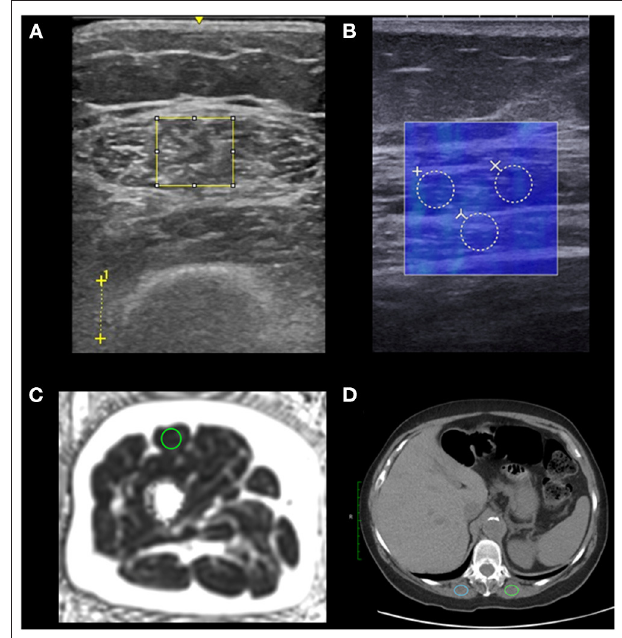
FIGURE 1 | Regions of interest (ROIs) used to analyze myosteatosis. We placed ROIs in the rectus femoris of the right leg using ultrasound and MRI ( n = 30), and ROIs in the erector spinae muscles using CT for older adults undergoing treatment ( n = 10). We placed the largest possible rectangular ROIs to assess echo intensity on brightness-mode ultrasound and used the distance between crosses to indicate 1cm to set image scale for measuring tissue thicknesses in post processing (A) . We placed three 3mm diameter circular ROIs which were averaged to assess shear wave speed measured by shear wave elastography. The shear wave speed measurements (in blue) are coregistered with a brightness-mode image to identify tissue locations (B) . We placed a 1 cm 2 circular ROI to assess proton density fat fraction using MRI (C) . We placed 2 ovular 2 cm 2 ROIs which were averaged to assess the muscle density using CT of older adults undergoing treatment (D)